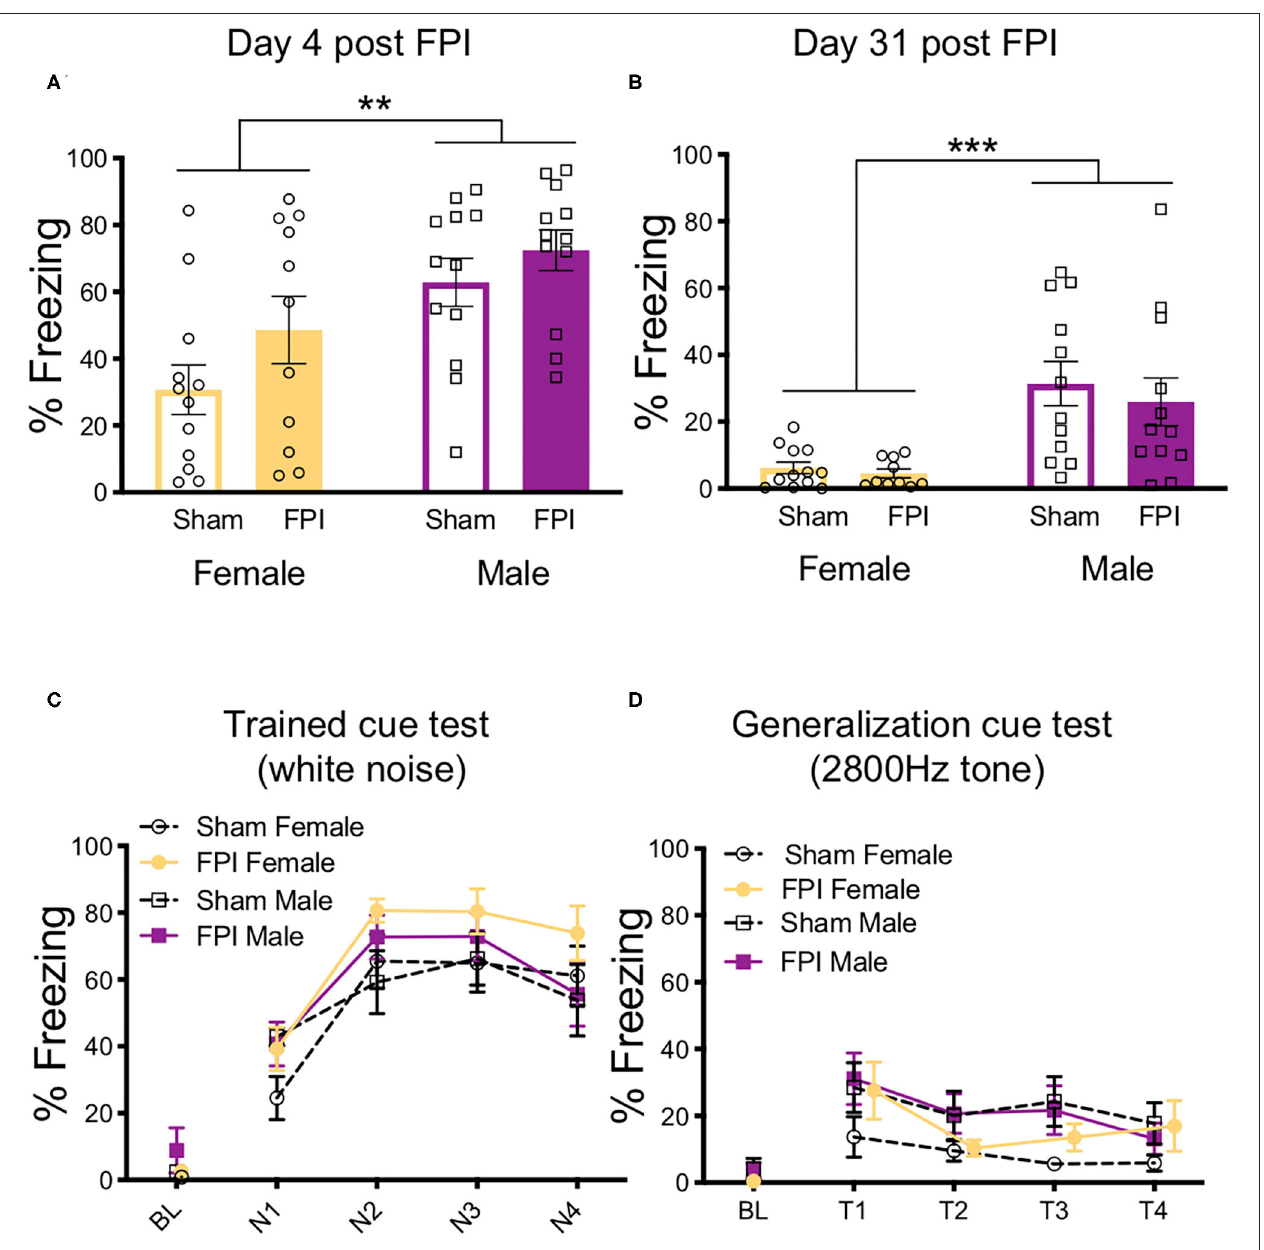
FIGURE 4 | Females have reduced contextual fear at recent and remote time points after auditory fear conditioning. (A) 24h after white noise-shock fear conditioning, (4 days post FPI), females displayed less fear to the context than males, regardless of FPI; ** p = 0.001. (B) Four weeks later, when tested for remote context fear (31 days post FPI), females showed little if any freezing to context and therefore less compared to males, regardless of FPI; *** p < 0.001. (C) 33 days post injury in a novel context, all groups showed intact fear to the trained white noise cue, with no effects of injury or sex. (D) 35 days post injury when tested for generalized auditory fear, there were no observed effect of sex or injury. Data are represented as mean ± SEM; n =